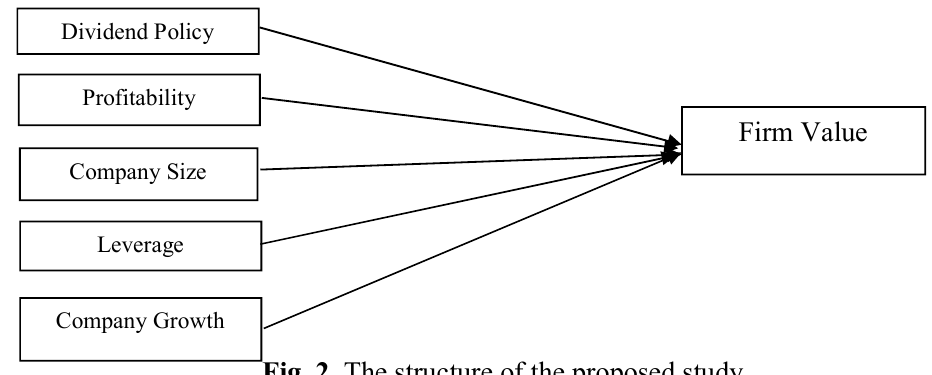
Fig. 2. The structure of the proposed